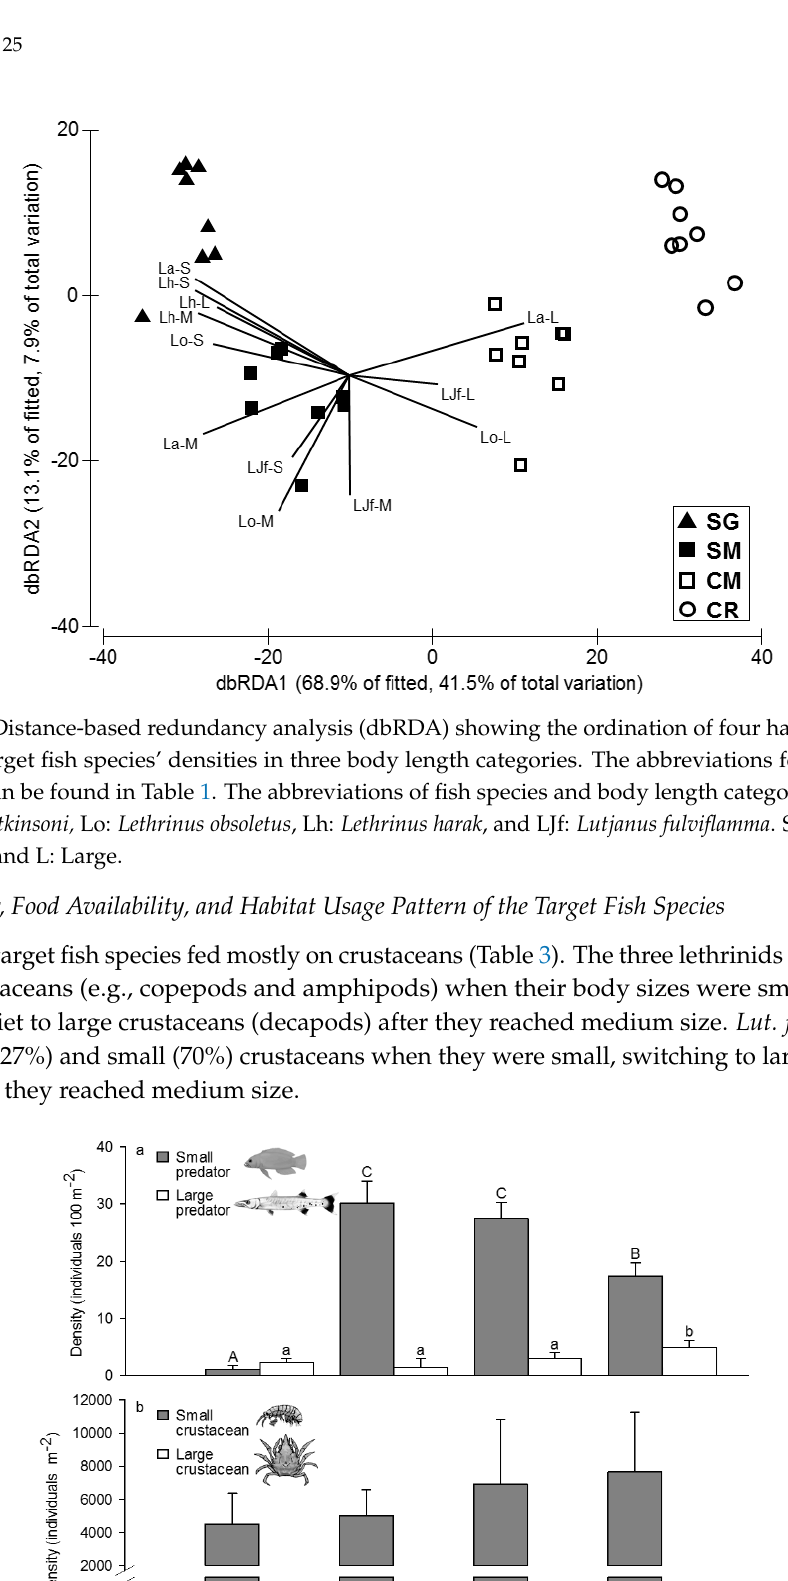
Figure 4. Densities of ( a ) piscivorous fish and ( b ) crustacean invertebrate prey in the four habitat types (see Table 1 for abbreviations.). The values represent means ± SE. The letters above the histograms denote post-hoc differences (capital letters for small predator and crustacean; lowercase letter for large predator and crustacean), if an overall difference was detected in the ANOVA (see Table 2.).